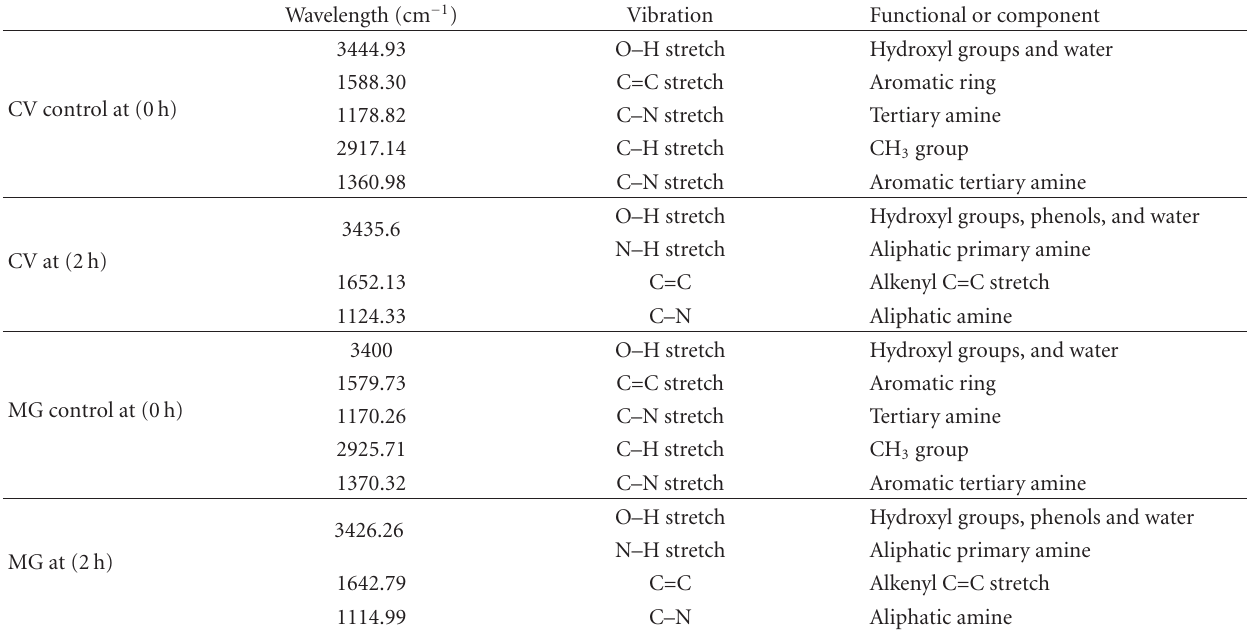
Table 2: Assignments of the FTIR spectral peaks of crystal violet (CV) and malachite green (MG).